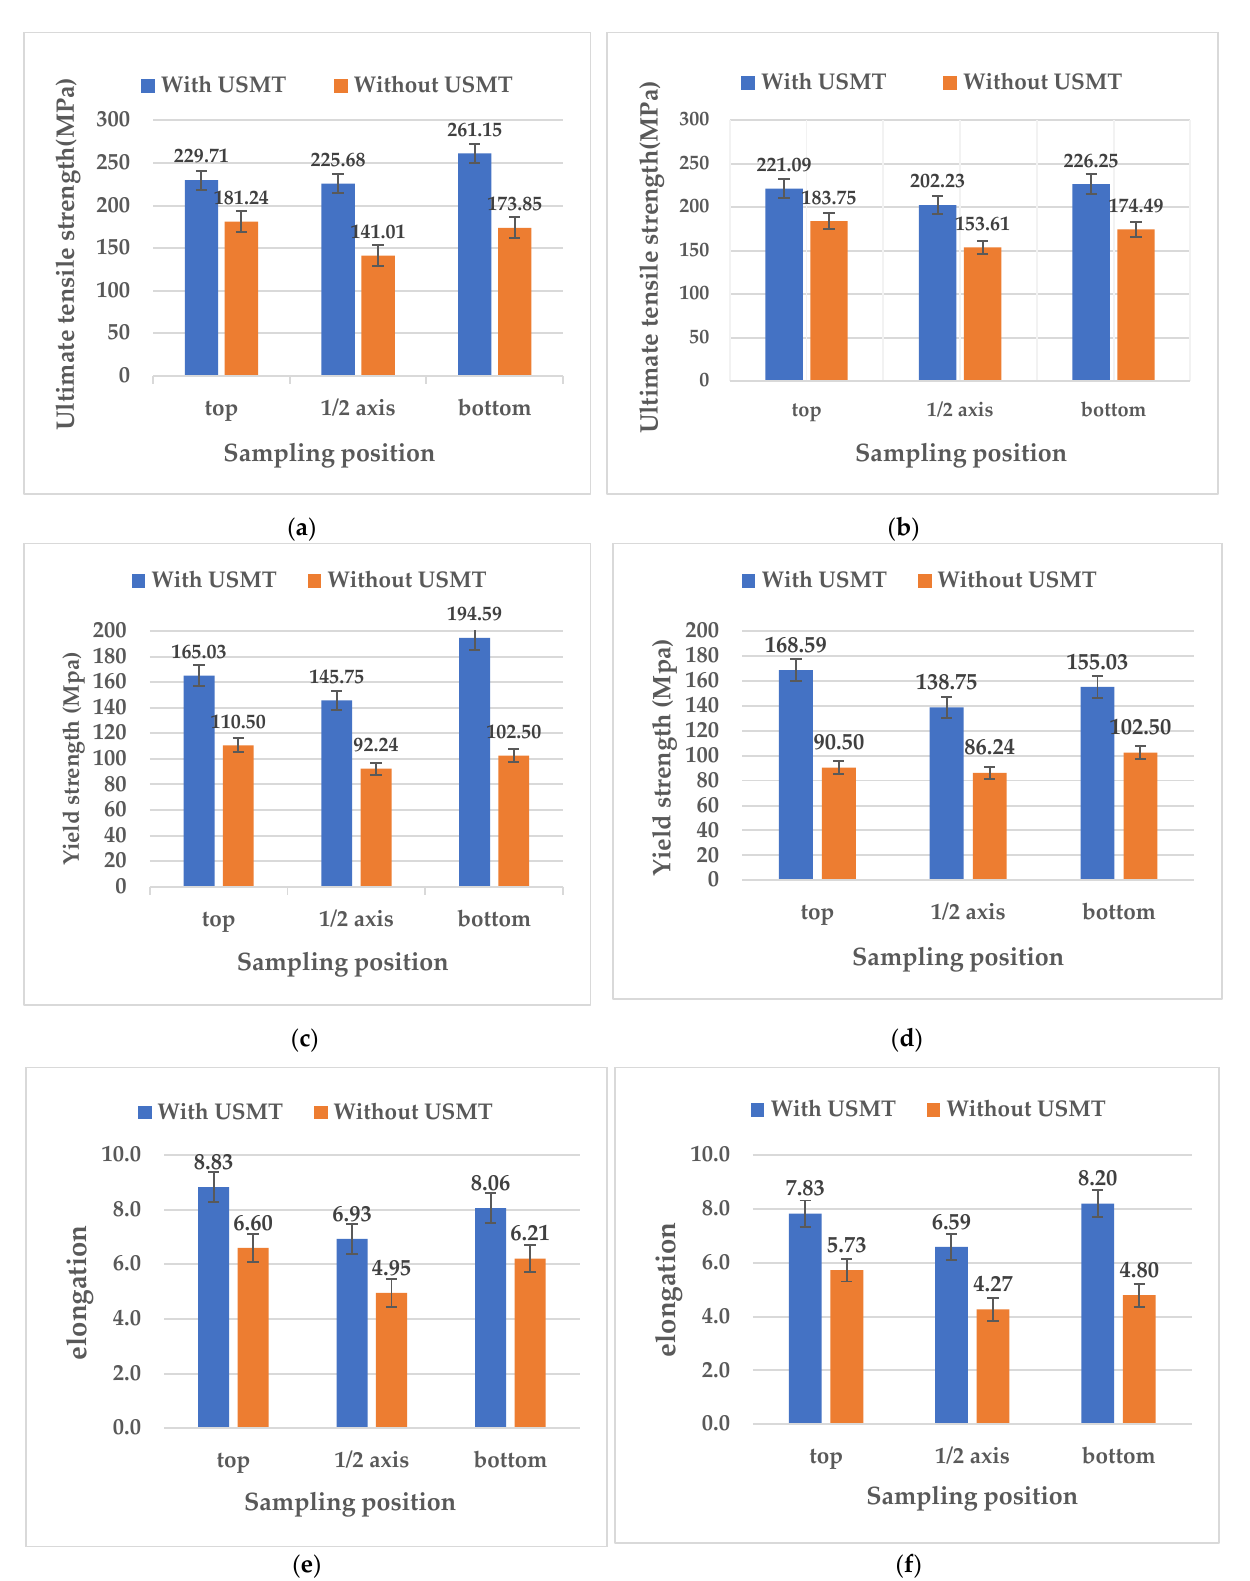
Figure 8. ( a,b ) Ultimate tensile strength (a, axial; b, radial) processed under different ultrasonic; ( c,d ) yield strength (c, axial; d, radial); and ( e,f ) elongation, determined at different positions of the ingot (e, axial; f, radial).